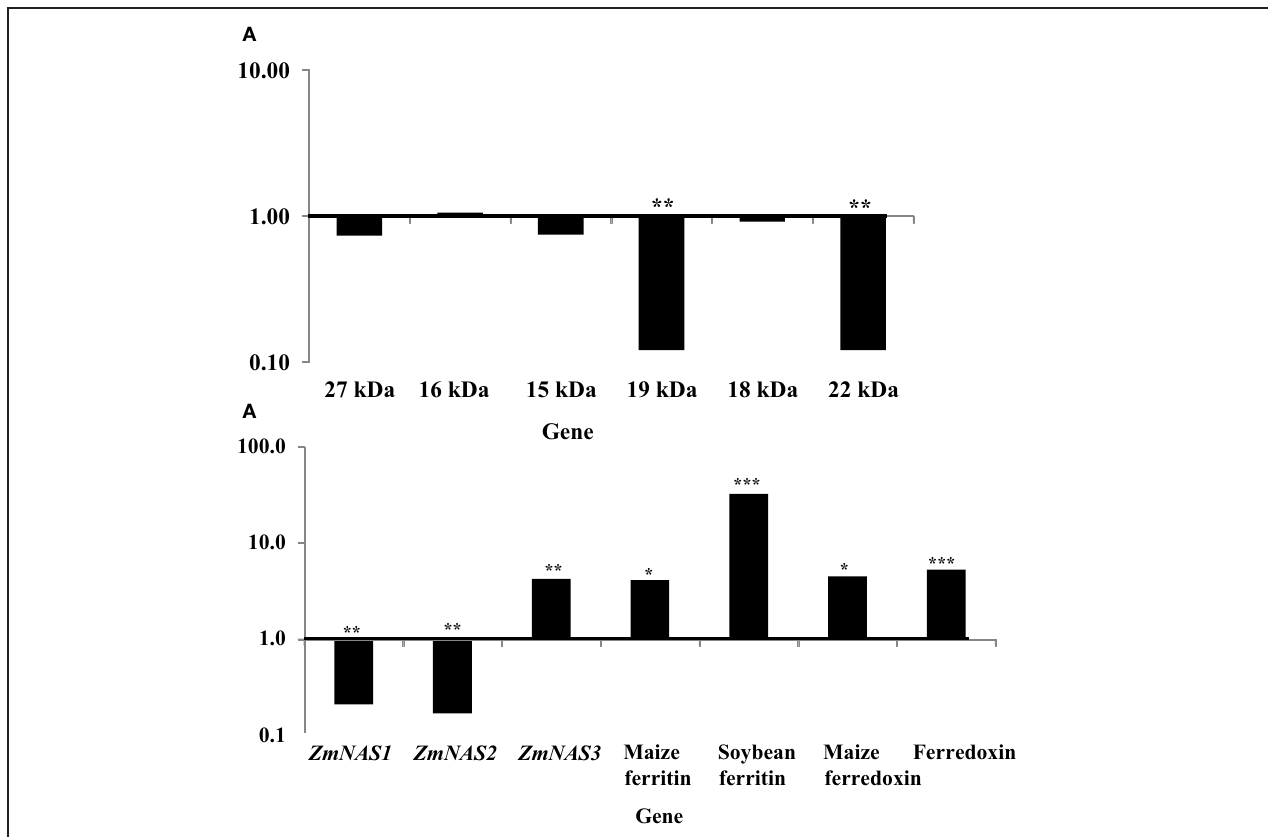
FIGURE 4 | mRNA transcriptchanges in maize seed endospermsamples harvested at 18 days after pollination (DAP). Maize seed endosperms were selected based on presence and absence of the soybean ferritin DNA. The 18DAP represents the time after the soybean ferritin transgene expression. Panels (A) and (B) represent qPCR analysis results for the maize seed storage protein genes (zeins) and iron homeostasis genes, respectively. For each gene,